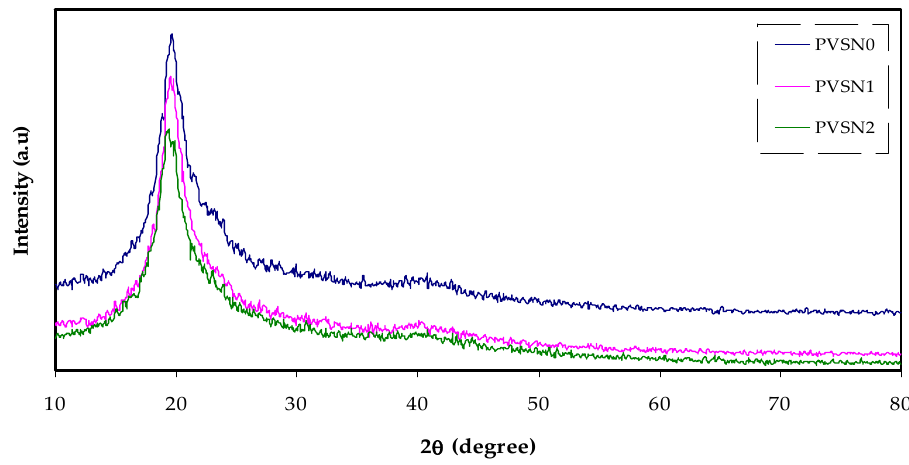
Figure 5. XRD spectra for pure PVA and doped films.